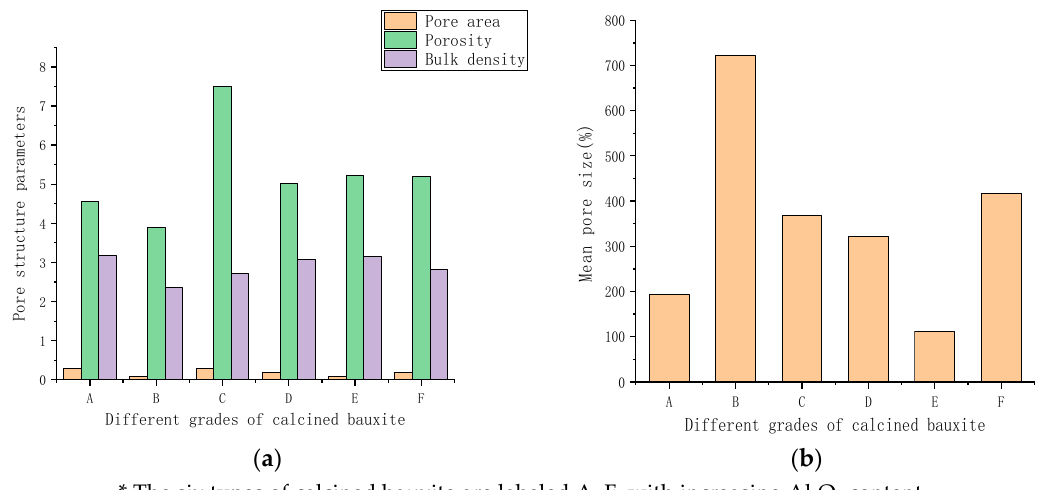
Figure 4. Pore structure parameters of different types of calcined bauxite.